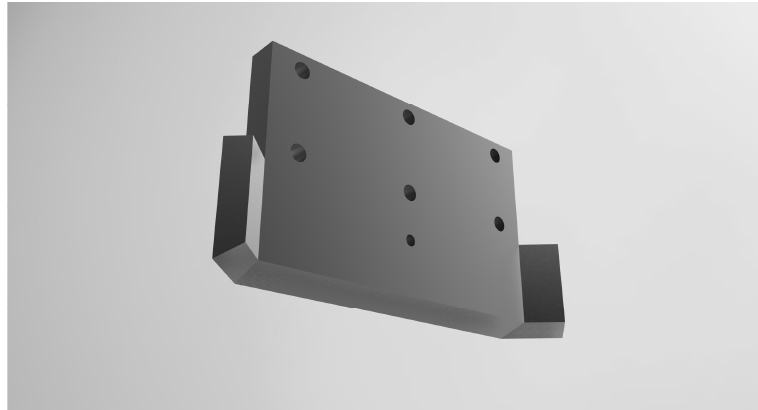
Figure 3. Blade shape.